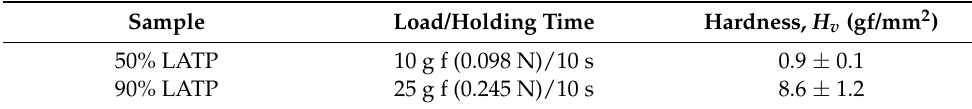
Figure 5. Scanning electron images of Vickers indentation of 50% LATP ( a ) and 90% LATP ( b ) composite electrolytes. Table 2. Hardness test of LATP-based composite solid electrolytes.